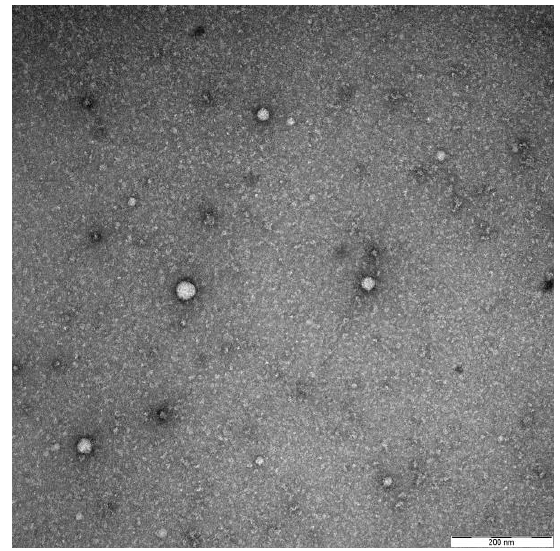
Figure 1. Representative electron microscopy picture by negative staining showing their typical appearance and size range. The exosomes were isolated as described previously from the plasma of a head and neck squamous cell carcinoma (HNSCC) patient [11].